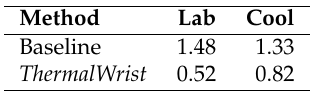
Table 3. Difference in standard deviation due to environmental